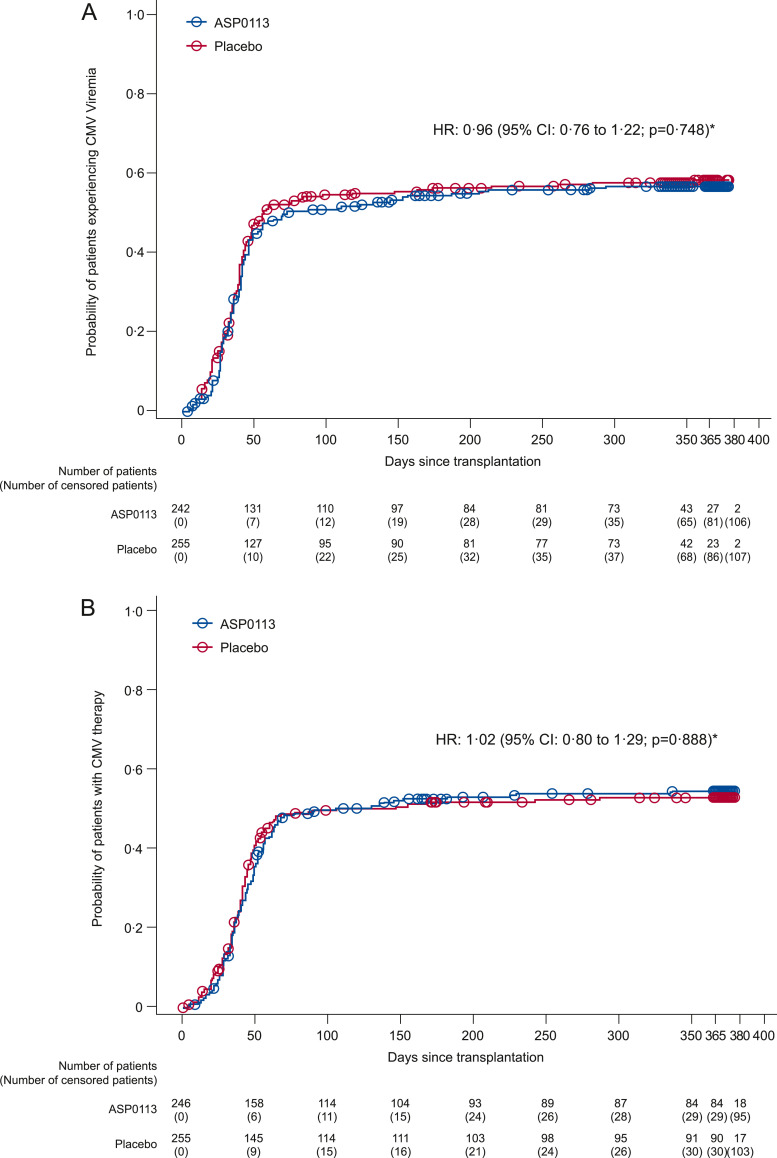
(A) Time to first protocol-defined CMV viraemia through 1 year post-transplant. (B) Time to first use of adjudicated CMV-specific antiviral therapy after first study vaccine injection through 1 year post-transplant *Parameter estimate from a Cox proportional hazards model with treatment and randomisation strata, adjusting for death as a competing risk. p-value based on Cox proportional hazards model parameter estimate for the treatment effect. Circles indicate censored observations. CMV=cytomegalovirus; HR=hazard ratio.